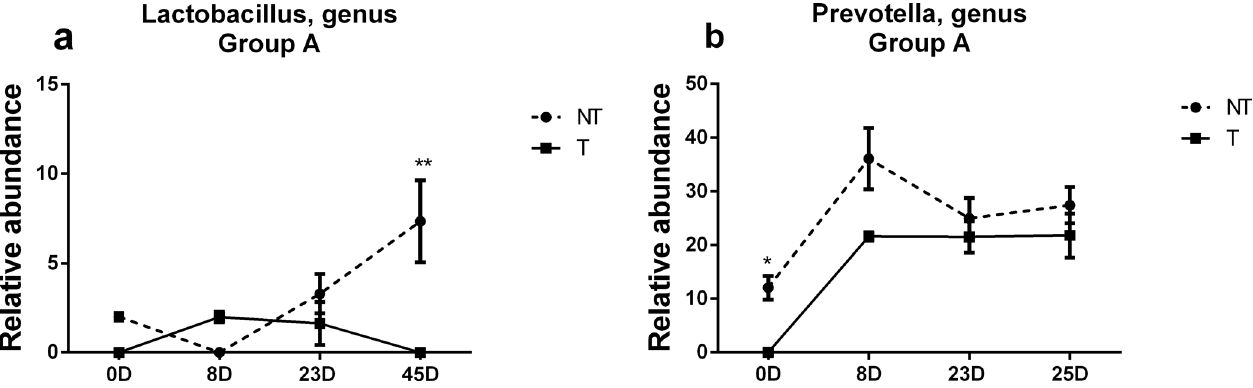
Fig 4. Different patterns in changes in genus level between transgenic and non-transgenic pigs post neomycin feedings in Group A. Comparison of changes in the levels of Lactobacillus (a) and genus Prevotella (b) at various time points (0D, 8D, 23 and 45D) post neomycin feeding between transgenic (T) and non-transgenic (NT) pigs. * : P <